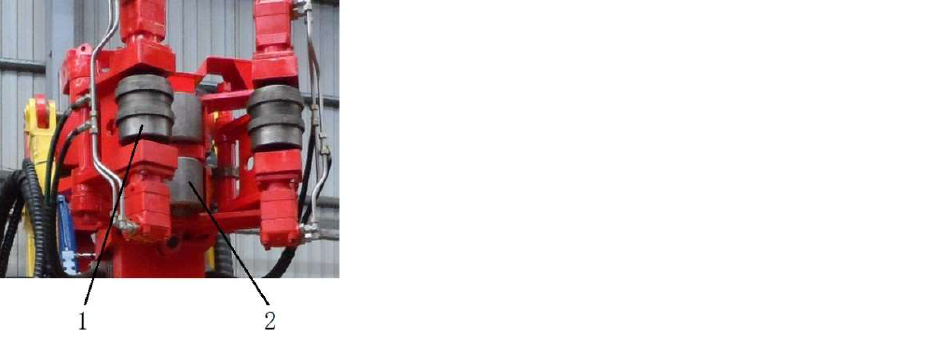
Figure 7. Spinner mechanism with single follow-up roller. In the figure: 1—driving roller, 2—fol- low-up roller. up roller.